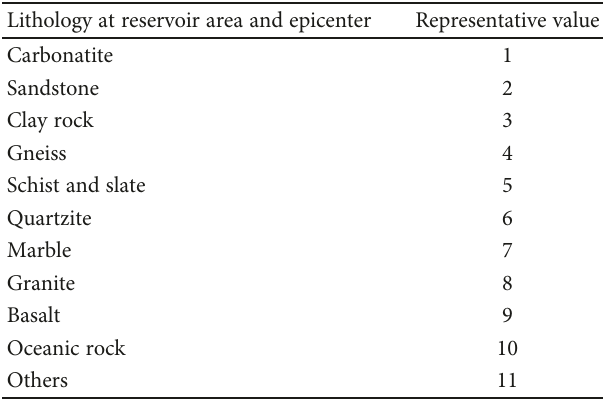
Table 3: Fault type.